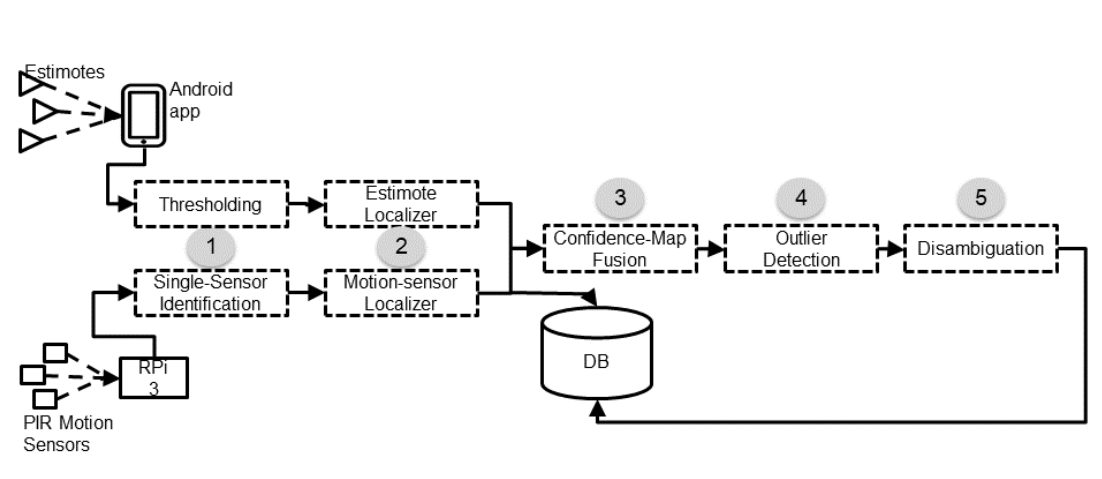
Figure 1. Structure of the proposed system. PIR: Pyroelectric (“Passive”) Infrared. DB: Data Base. RPi: Raspberry Pi